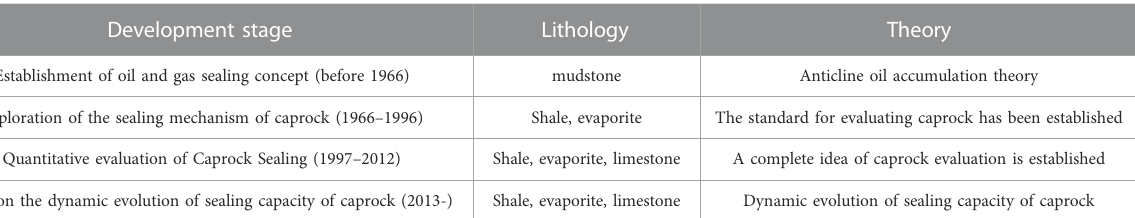
TABLE 1 Development history of cap sealing